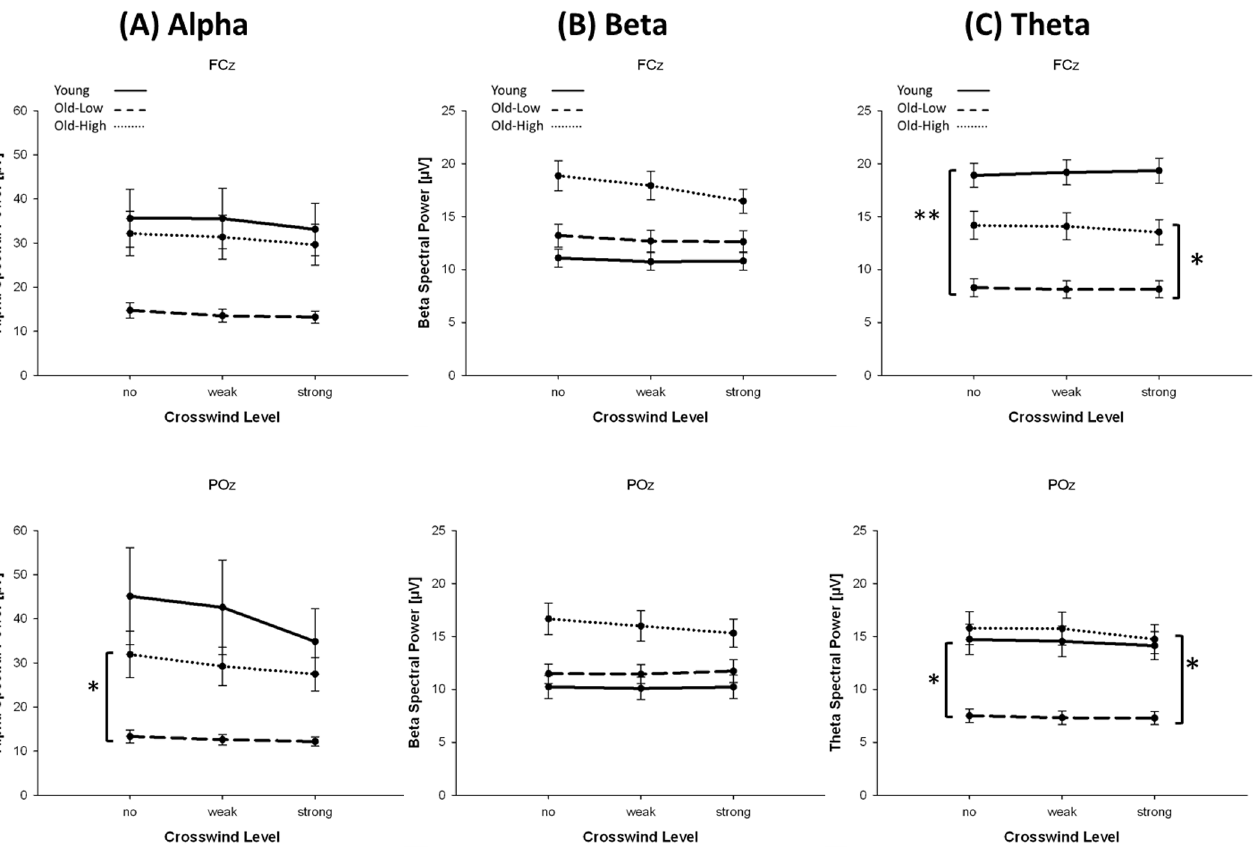
Fig 3. Oscillatory brain activity in different frequency bands. Spectral power (means and standard errors of means) of fronto-central and posterior Alpha (A), (overall) Beta (B) and Theta (C) band as function of crosswind level (no, weak, strong), shown for younger participants and older participants with high (Old- High) and low (Old-Low) driving lane variability. Significant group differences are indicated by asterisks; (cid:3) p < .05; (cid:3)(cid:3) p <